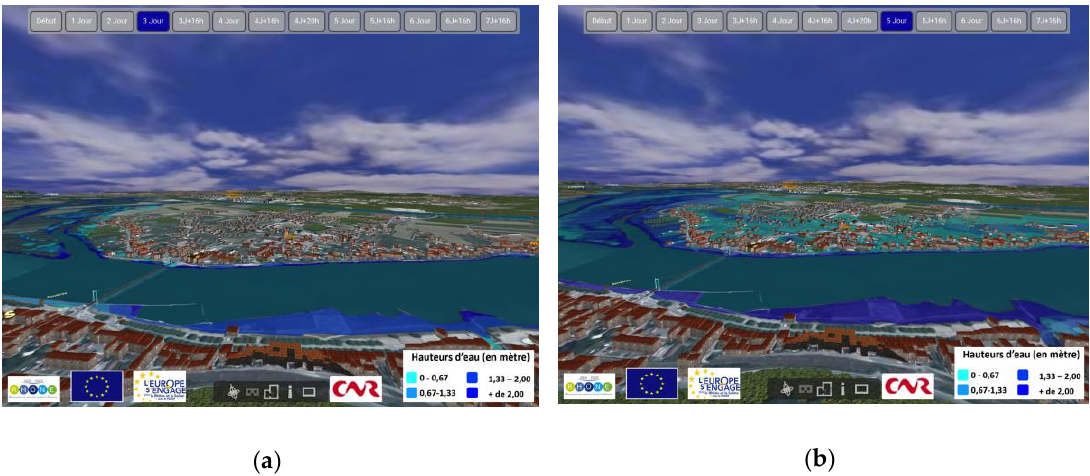
Figure 3. Two images from two different moments in the simulated flood, from a high vantage point: ( a ) shows water height at day three (three days after the beginning of the simulated flood); ( b ) shows water heights at day five.